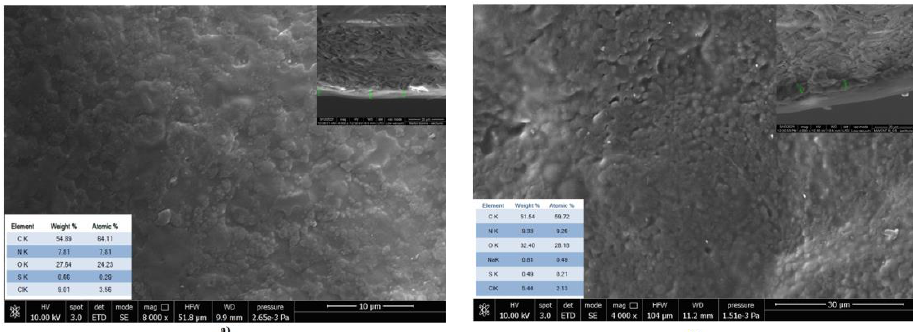
Figure 9. SEM images of bovine leathers ( a ) control and ( b ) MWCNT_B_0.5 for the surface with the inset images of cross sections and finishing layer measurement and elemental composition tables.